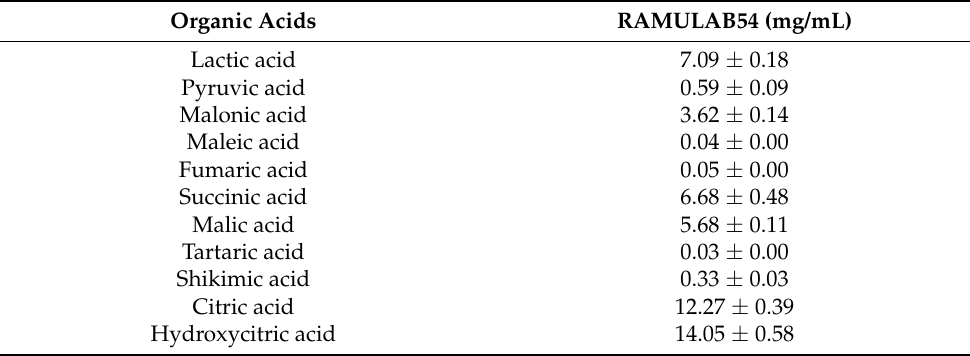
Table 8. Organic acid profile of the RAMULAB54.